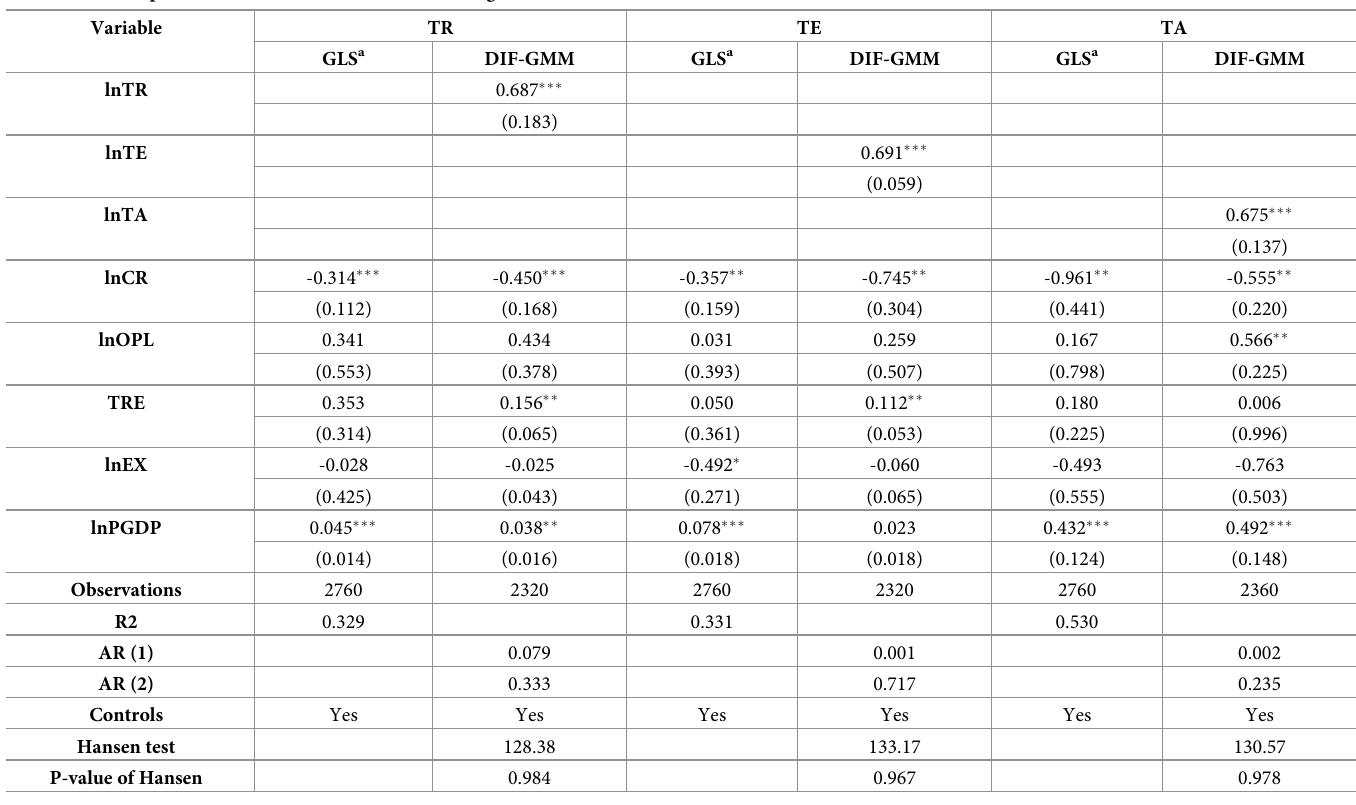
Table 11. The impact of CR on international tourism using different methods. Variable